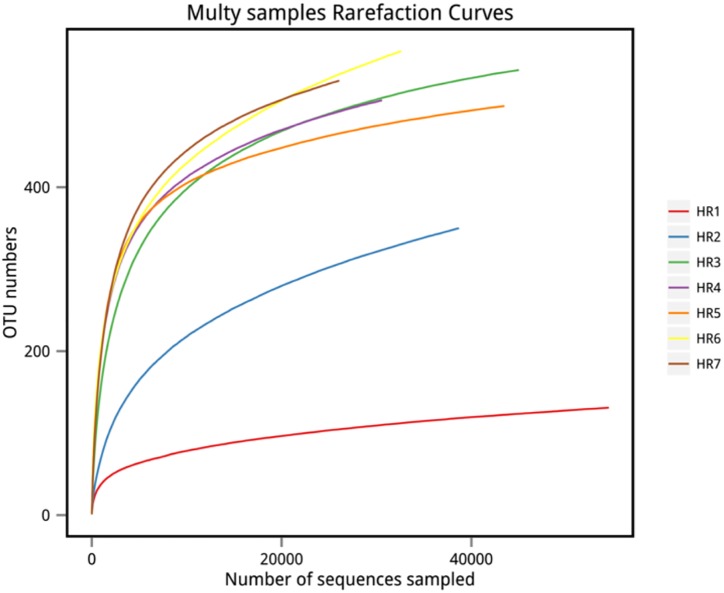
Rarefaction curves of OTU richness among samples. OTU richness was determined via sequencing of the V5–V7 hypervariable regions of 16S rRNA genes.